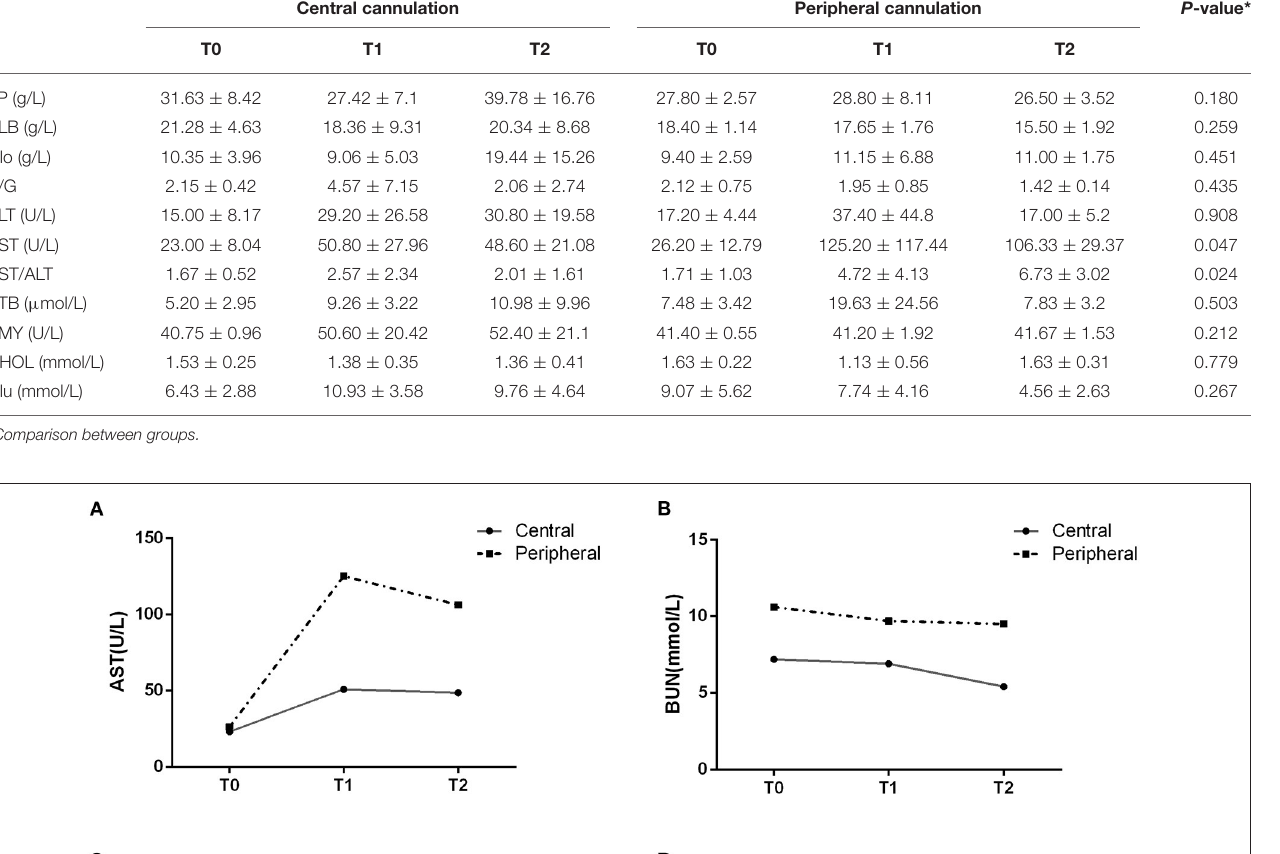
TABLE 3 | Liver function tests. Central cannulation Peripheral cannulation